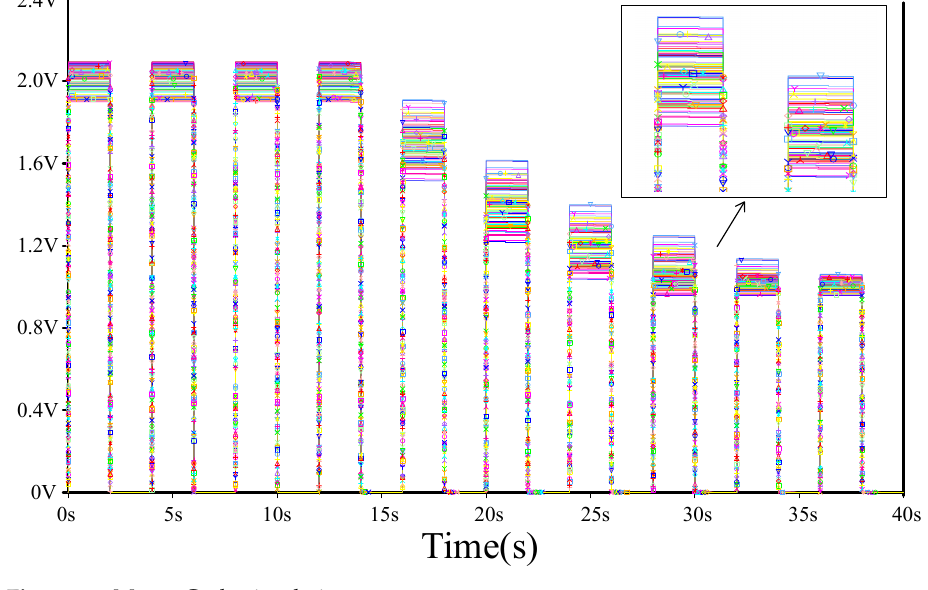
Figure 16. Monte Carlo simulation. Table 3. Comparison of functions implemented by several different